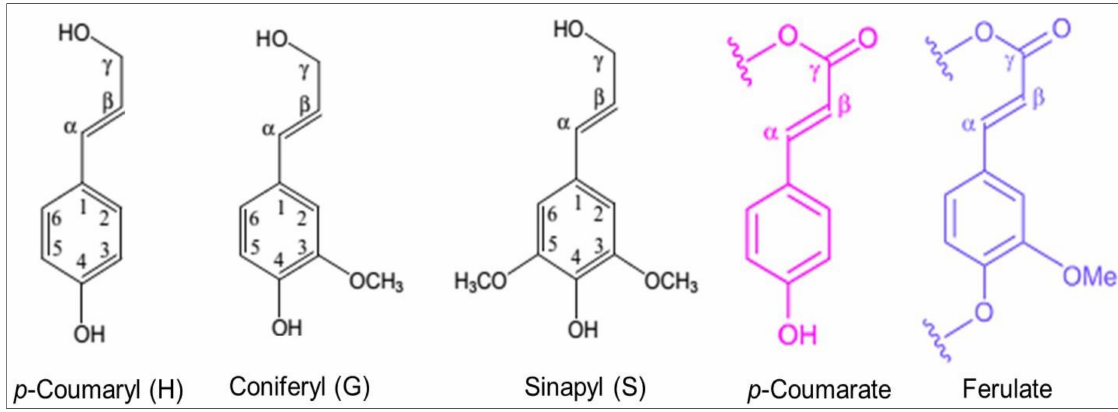
Figure 4. Lignin monomer units